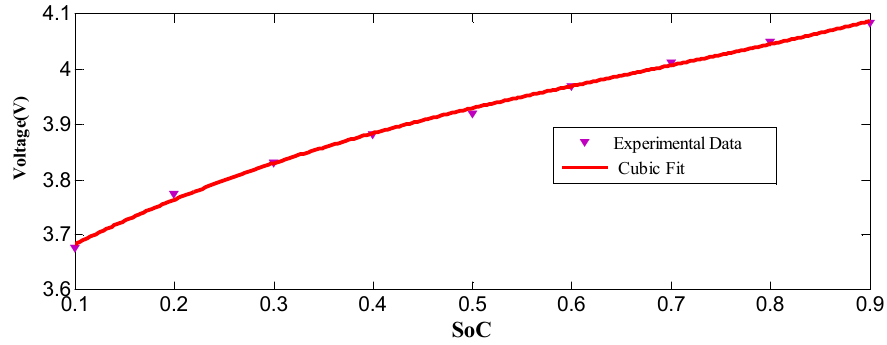
Figure 2. The open-circuit voltage experimental data and curve fitting